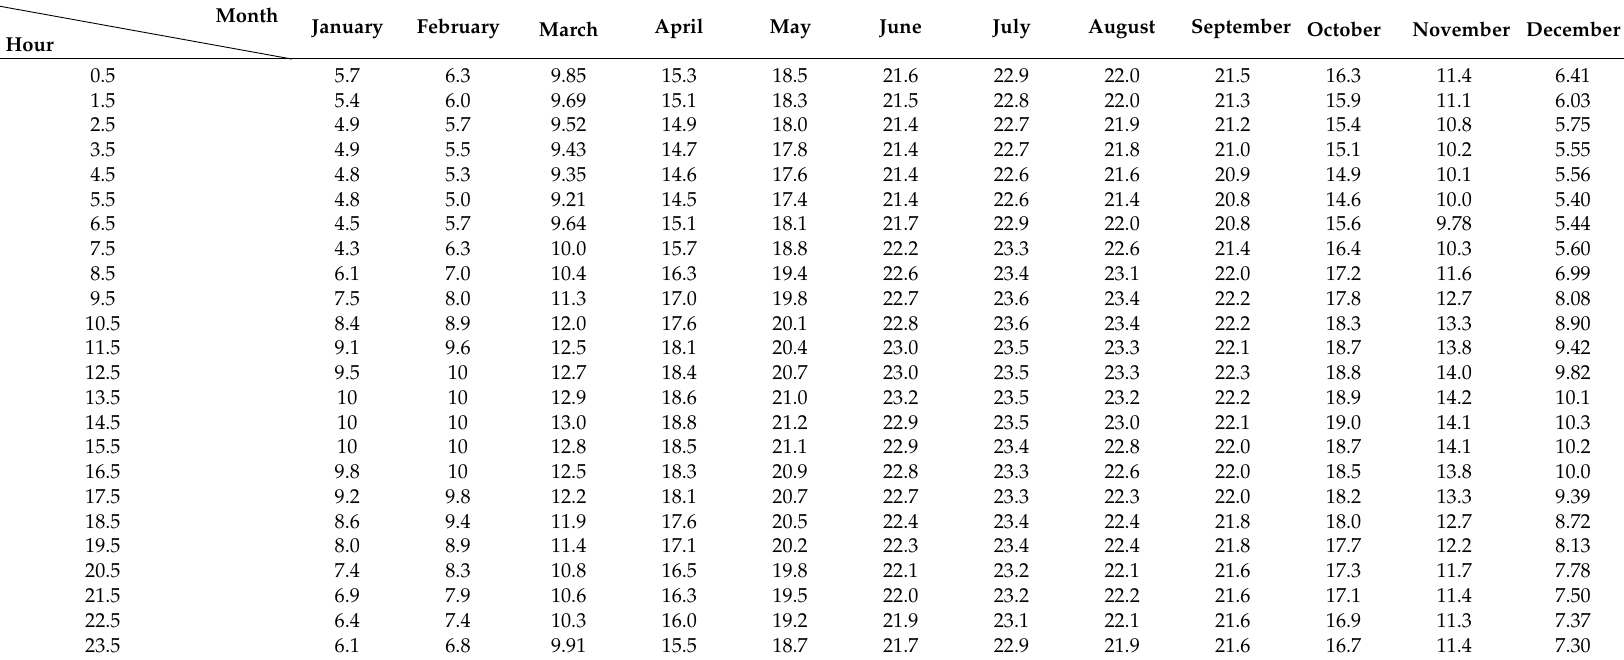
Table A2. Average hourly wet bulb temperature ( ◦